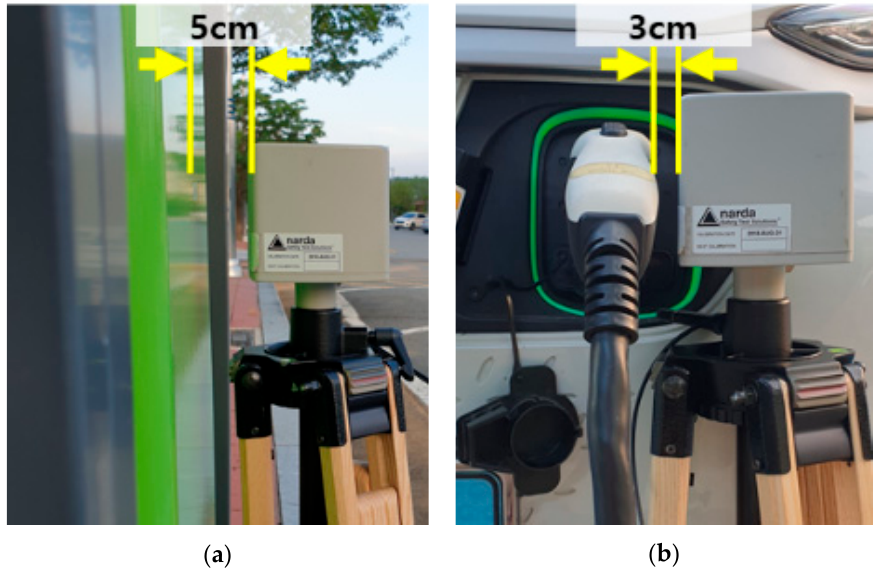
Figure 3. Distance between the meter and charger: ( a ) main body; ( b ) handle.